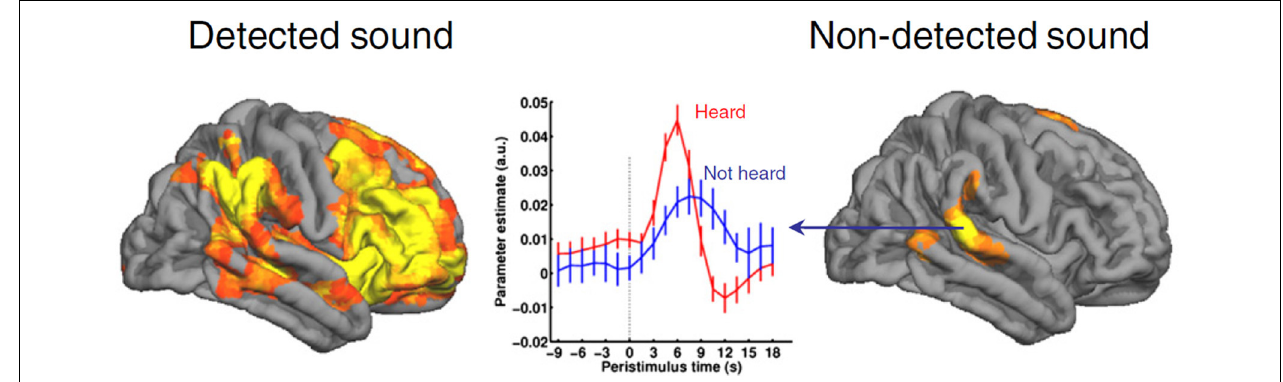
FIGURE 1 | Consciousness is not correlated with activation of primary sensory cortex. This example of contrastive analysis demonstrates activation of primary auditory cortex even in the absence of conscious perception. By